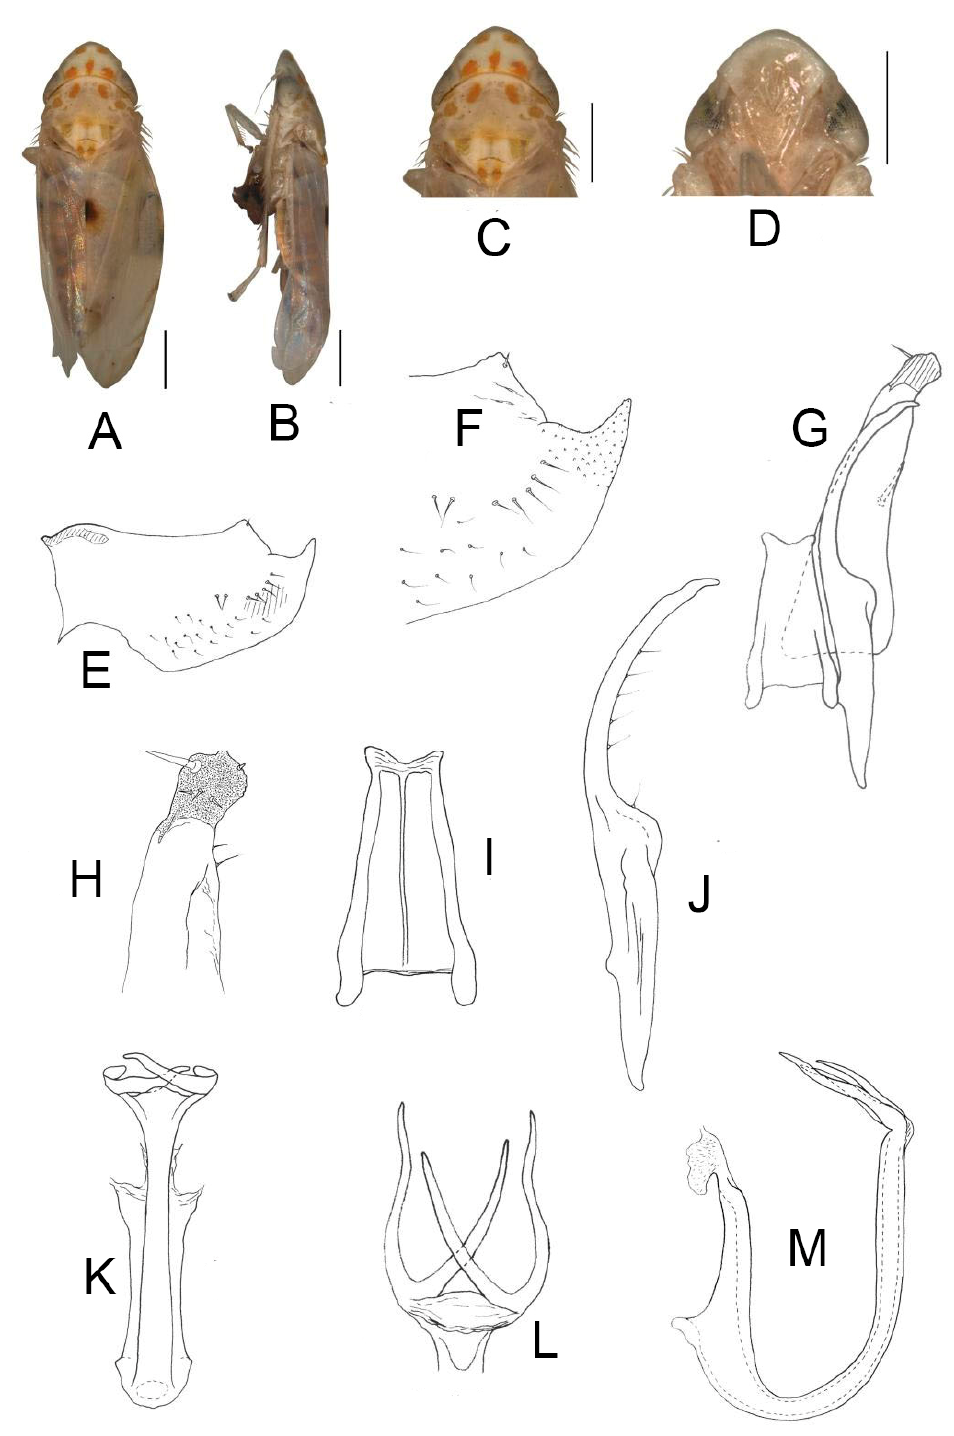
Figure 12. Eurhadina ( Singhardina ) centralis: ( A ) habitus, dorsal view; ( B ) habitus, lateral view; ( C ) head and thorax, dorsal view; ( D ) face; ( E ) male pygofer side, lateral view; ( F ) hind part of pygofer, lateral view; ( G ) subgenital plate, connective and paramere, dorsal view; ( H ) apex of subgenital plate, dorsal view; ( I ) connective, dorsal view; ( J ) paramere, dorsal view; ( K ) aedeagus, posterior view; ( L ) apex of aedeagal shaft, dorsal view; and ( M ) aedeagus, lateral view. Scale bars: 0.5 mm. Eurhadina ( Singhardina ) choui Huang et Zhang, 1999 Eurhadina ( Singhardina ) choui Huang et Zhang, 1999: 247, Figure 2 [8]. Material examined. 2 ♂ , China, Fujian Prov., Mt. Wuyi, 2008.VIII.17, coll. Xia Gao and Xiaoting Li; 1 ♂ , China, Fujian Prov., Mt. Wuyi, 2008.VIII.16, coll. Xia Gao and Xiaoting Li; 1 ♂ , China, Fujian Prov., Mt. Fengyang, 2008.VIII.01, coll. Xia Gao and Xiaoting Li.